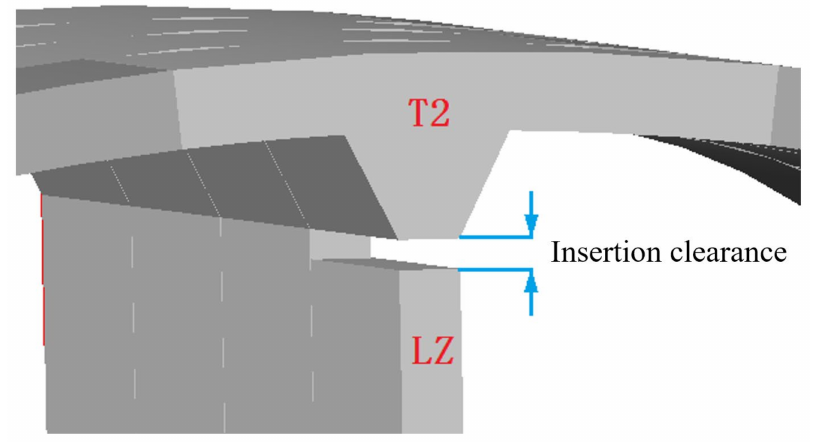
Figure 9. Schematic diagram of the LZ insertion gap.